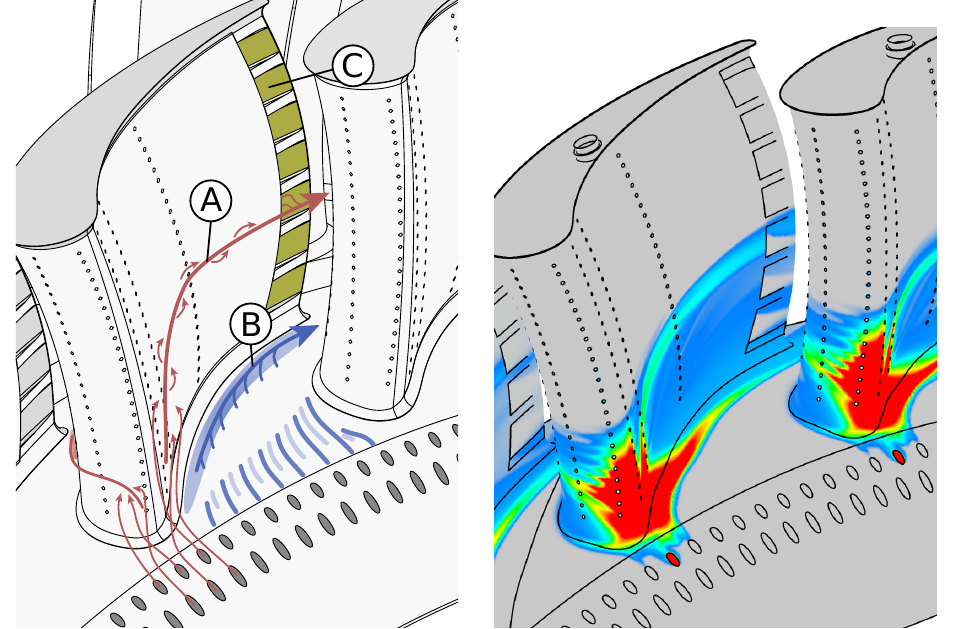
Figure 9. Model of RIDN coolant flow features: ( left ) RIDN flow evokes vortex (label A ) at the leading edge, that carries coolant flow up on the pressure side surface and is also fed by trailing edge flow coolant (label C ). The coolant accumulates in the pressure side corner due to the high momentum (label B ); ( right ) Comparison with CFD predictions of coolant flow from a single RIDN hole in front of the vane leading